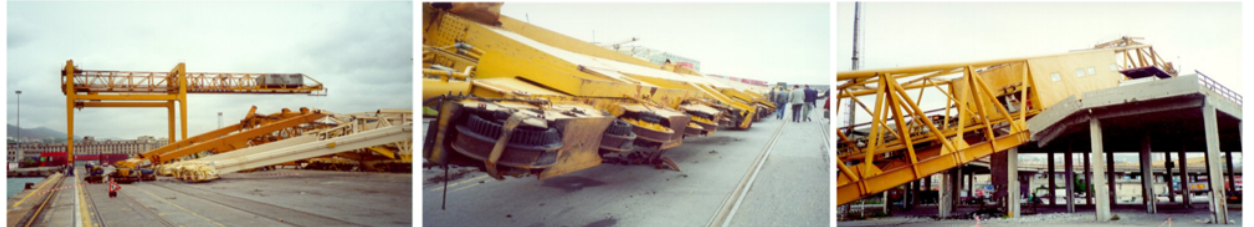
Figure 3. Damages caused by the thunderstorm downburst that occurred in the port of Genoa (Italy) on 31 August 1994 (Photos by the